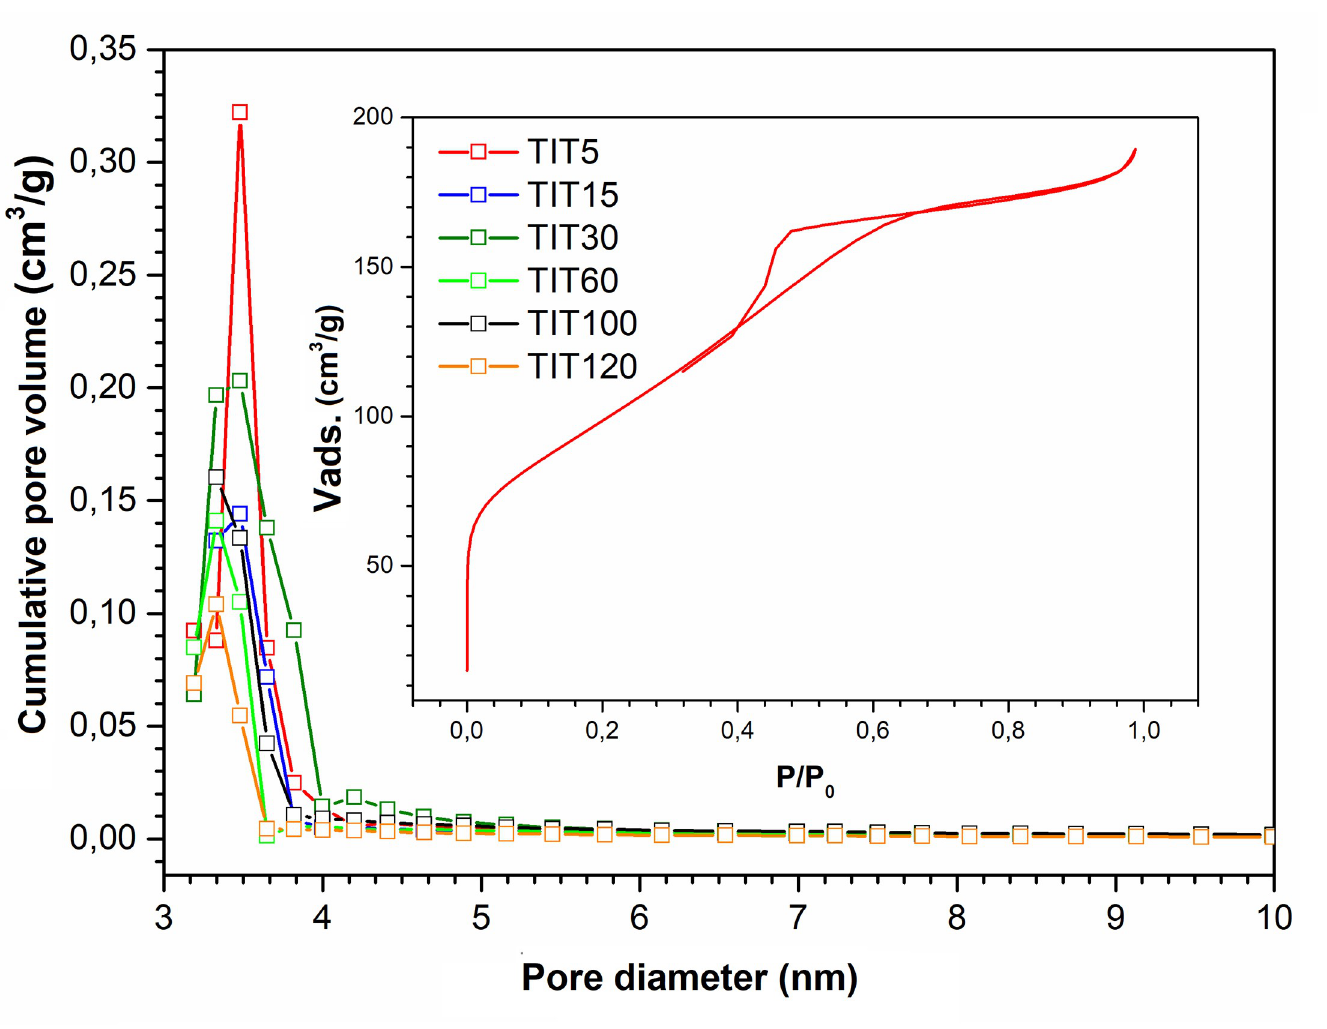
Fig 2. The porosity of TiO 2 samples. Inset: a hysteresis loop.